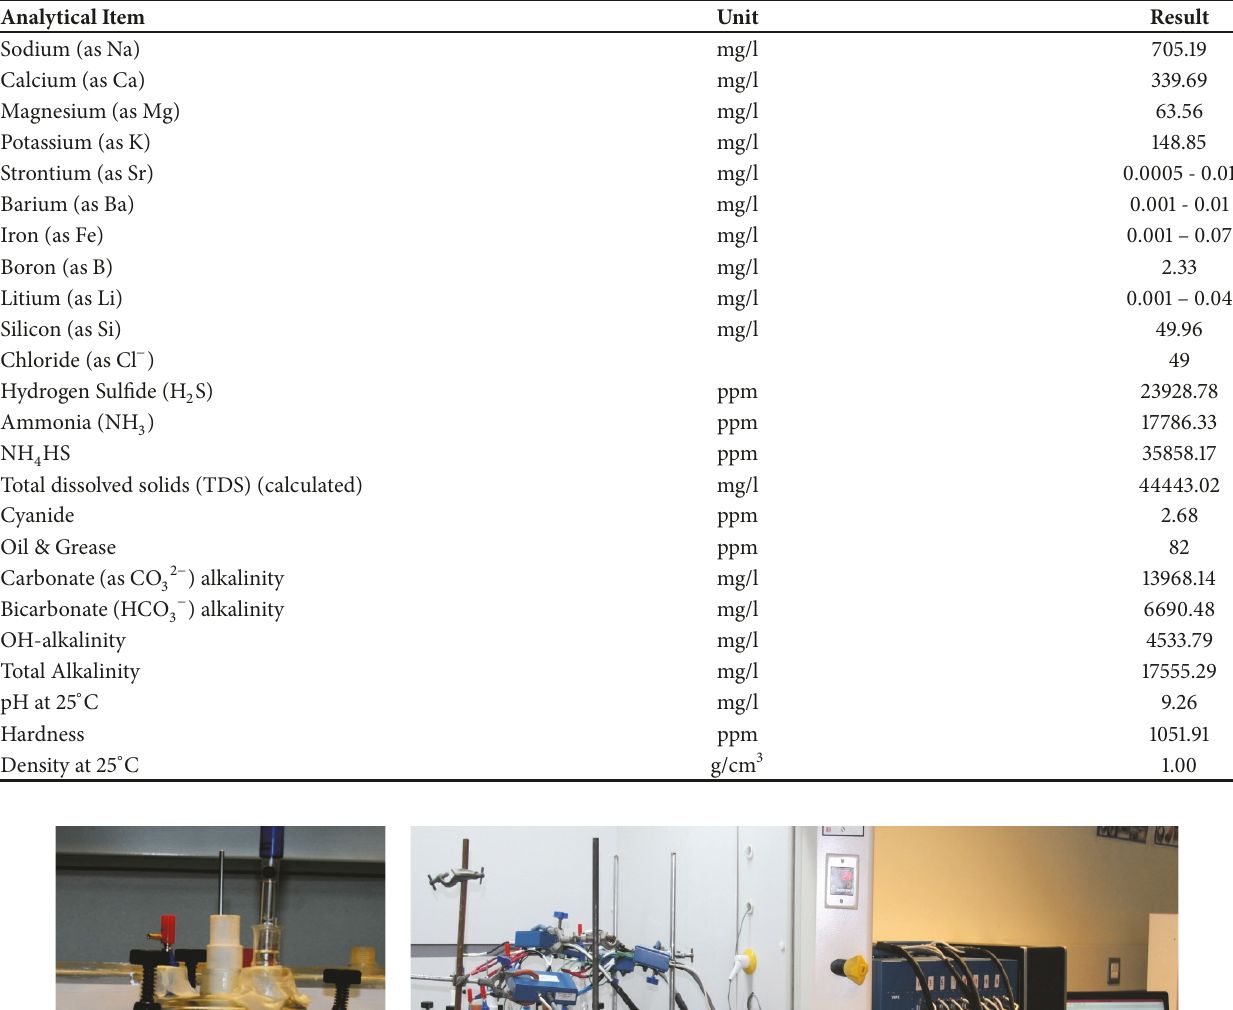
Table 2: Chemical composition of ABS solution.